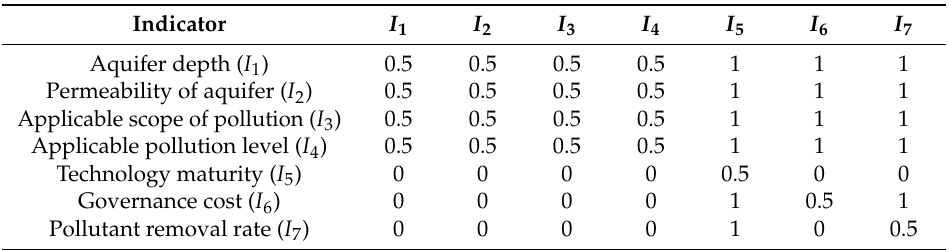
Table 3. Precedence relation matrix.